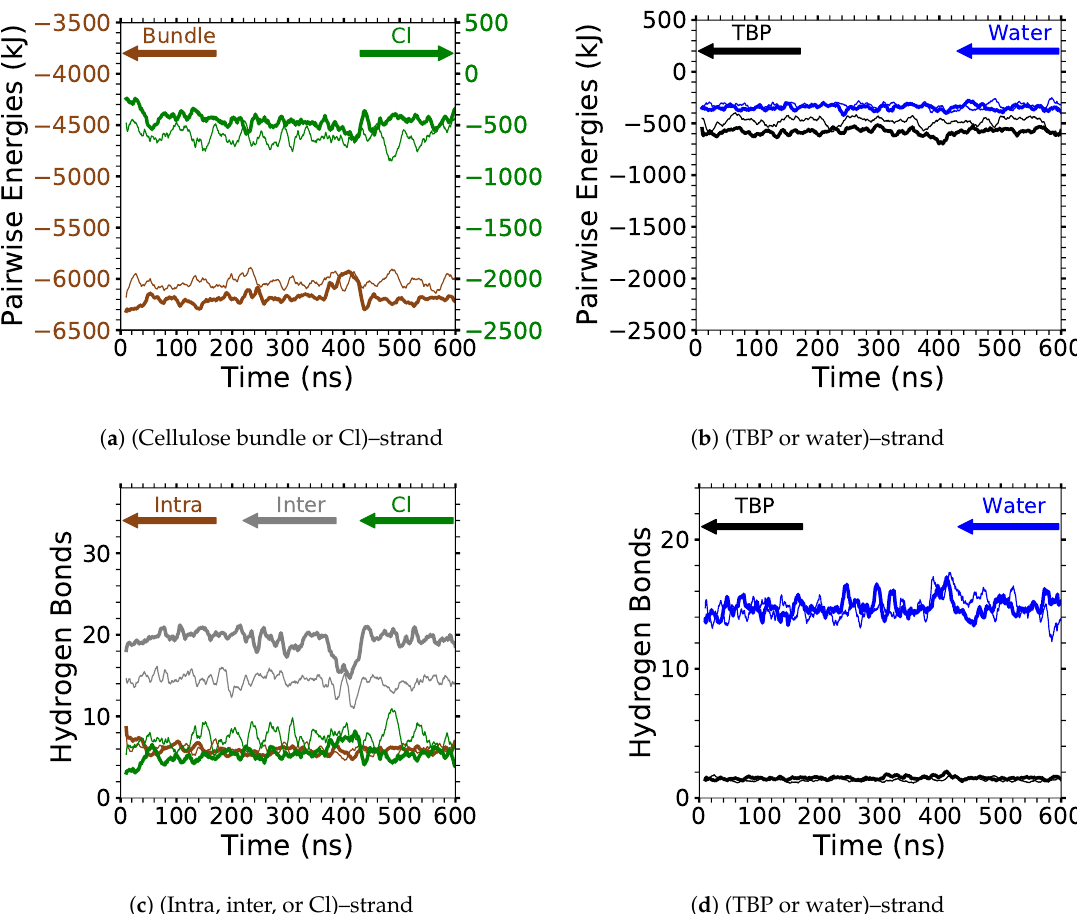
Figure A18. Pairwise energies and hydrogen bonding of the peeling strand(s) at 93.9mol%water and 360K. The pairwise energies of the separating strand(s) between the: ( a ) (cellulose bundle or Cl)–separating strand; ( b ) (TBP or water)–separating strand. The number of hydrogen bonds for the separating strand(s) per the given type: ( c ) (intra, inter, or Cl)–separating strand; ( d ) (TBP or water)–separating strand. The thick line is the first yellow strand to peel, and the thin line is the non-peeling yellow strand or second strand to peel. If neither of the stands peel, then both the thick and thin lines are non-peeling yellow strands. The data were averaged over 1000 data points, using a rolling